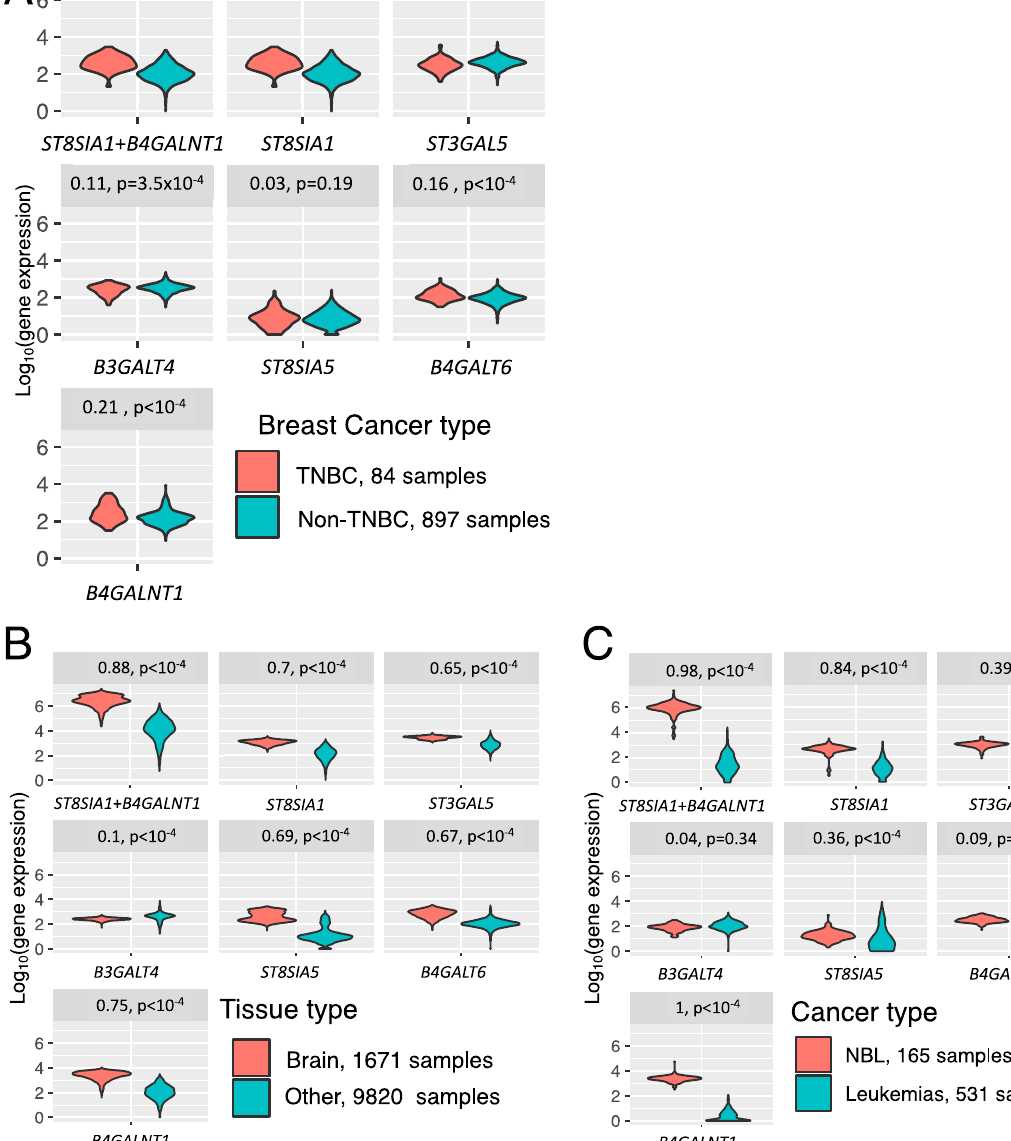
Figure 5. Difference in gene expression and the 2-gene signature score between putative GD2-positive (red) and putative GD2-negative (cyan) cancers and healthy tissue types. ( A ) TCGA dataset, n = 981 samples , ( B ) GTEx dataset, n = 11,491 samples, ( C ) TARGET dataset, n = 696 samples. Matthews Correlation Coefficient values (left) and p -values (right) are shown for each individual ganglioside biosynthesis gene or the 2-gene signature.